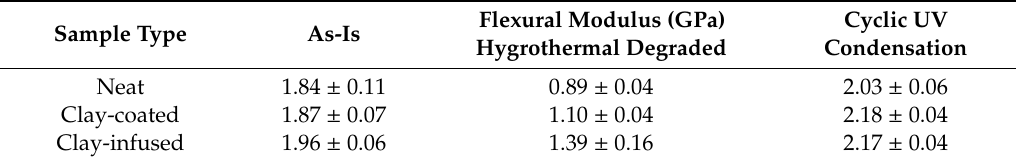
Table 2. Flexural modulus of carpet composites.